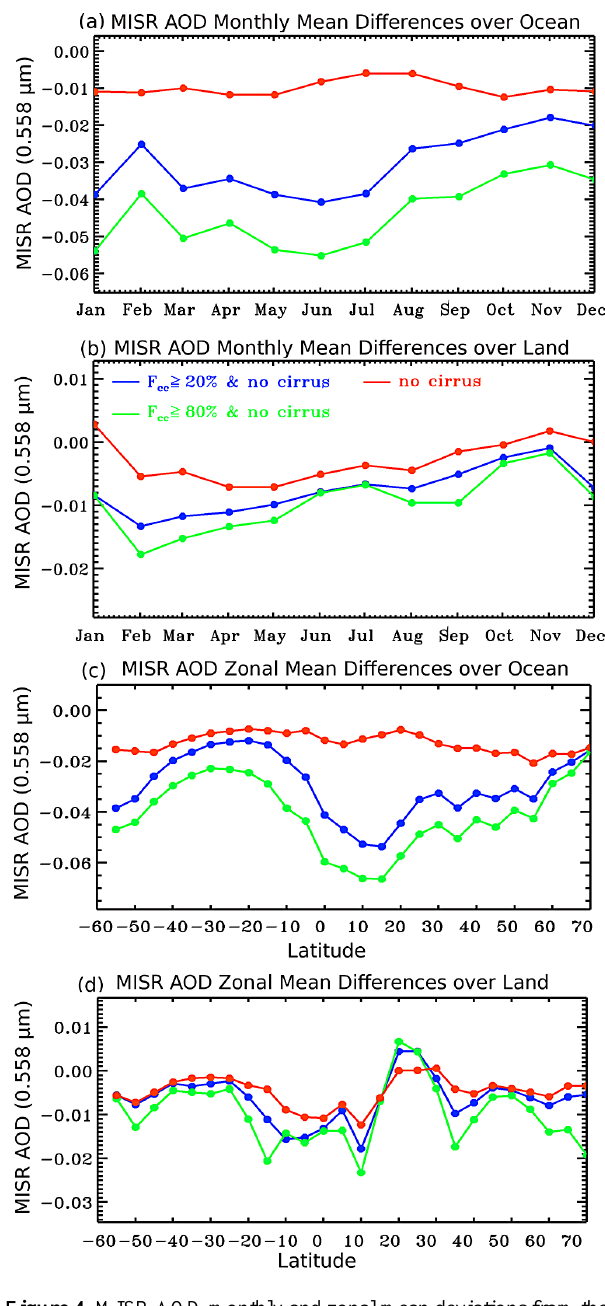
Figure 4. MISR AOD monthly and zonal mean deviations from the self-QAed MISR AOD for 2007 (minus self-QAed). (a) the over- water monthly mean, (b) the over-land monthly mean, (c) the over- water zonal mean, and (d) the over-land zonal mean. Three data sets are plotted, representing the data that passed the thin cirrus cloud filter ( F cirrus_free = 100%) in red, data that passed F cc > 20% and F cirrus_free = 100% filters in blue, and data that passed F cc > 80% and F cirrus_free = 100% filters in